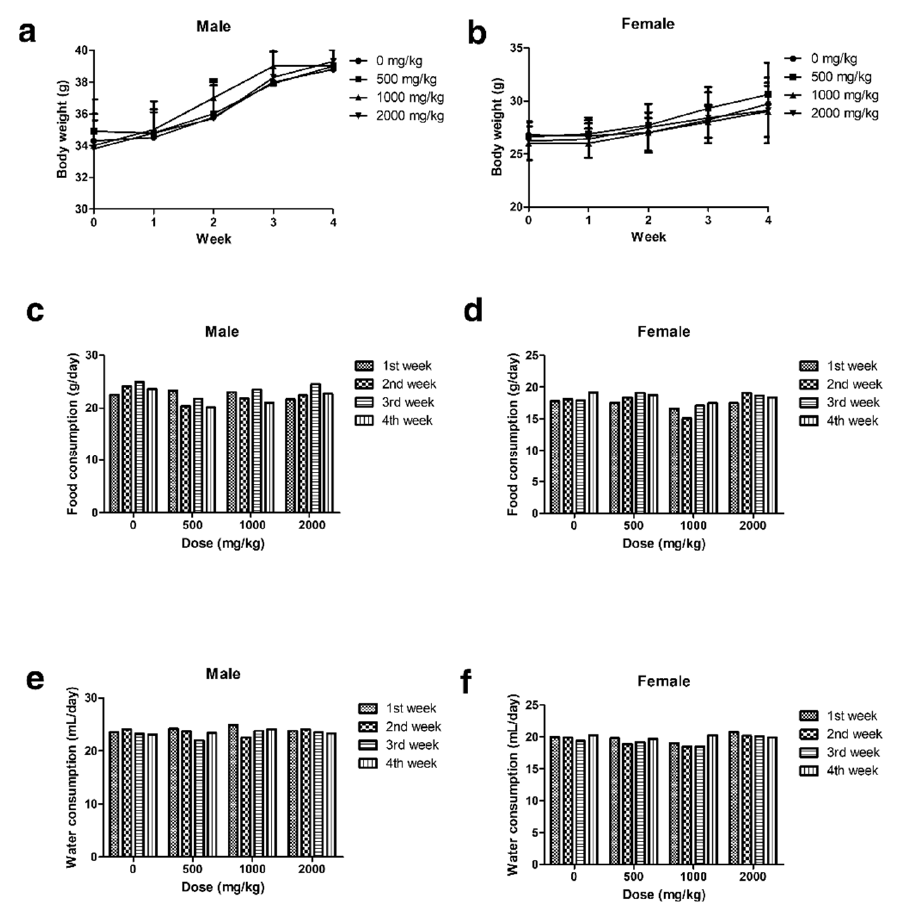
Figure 3. ( a , b ) Body weight of male and female mice measured once a week during 4 weeks following a repeated oral dose of polyethylene microplastics. ( c , d ) Food and ( e , f ) water consumption of male and female mice measured once a week during 4 weeks during a 28-day repeated oral dose toxicity study.